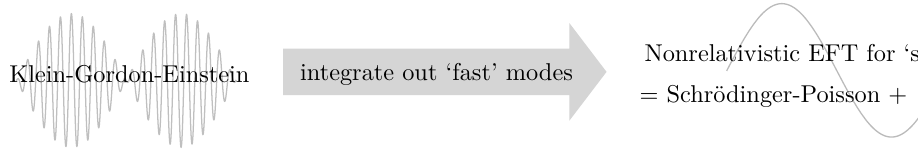
Figure 1 . Schematic approach of our EFT method for identifying systematic corrections to the Schrödinger-Poisson